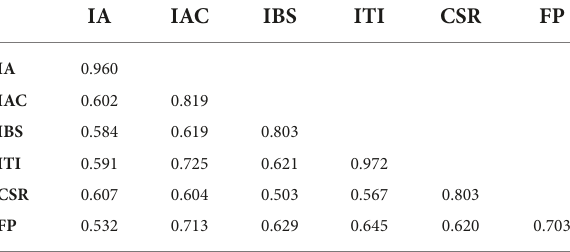
TABLE 2 iscriminant validity (Fornell larker criterion).